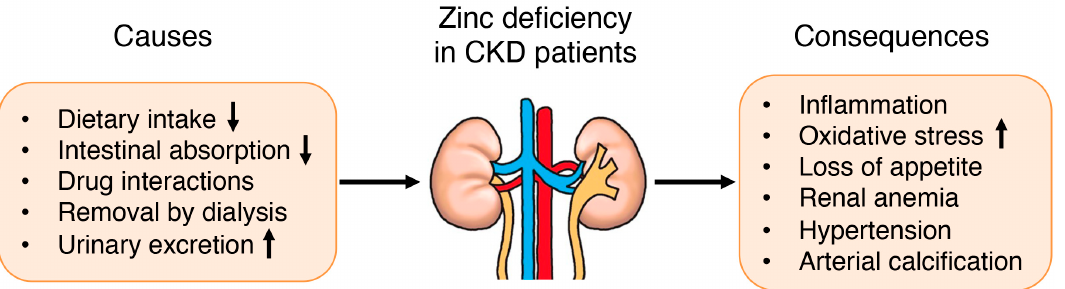
Figure 1. Causes and consequences of zinc deficiency in patients with